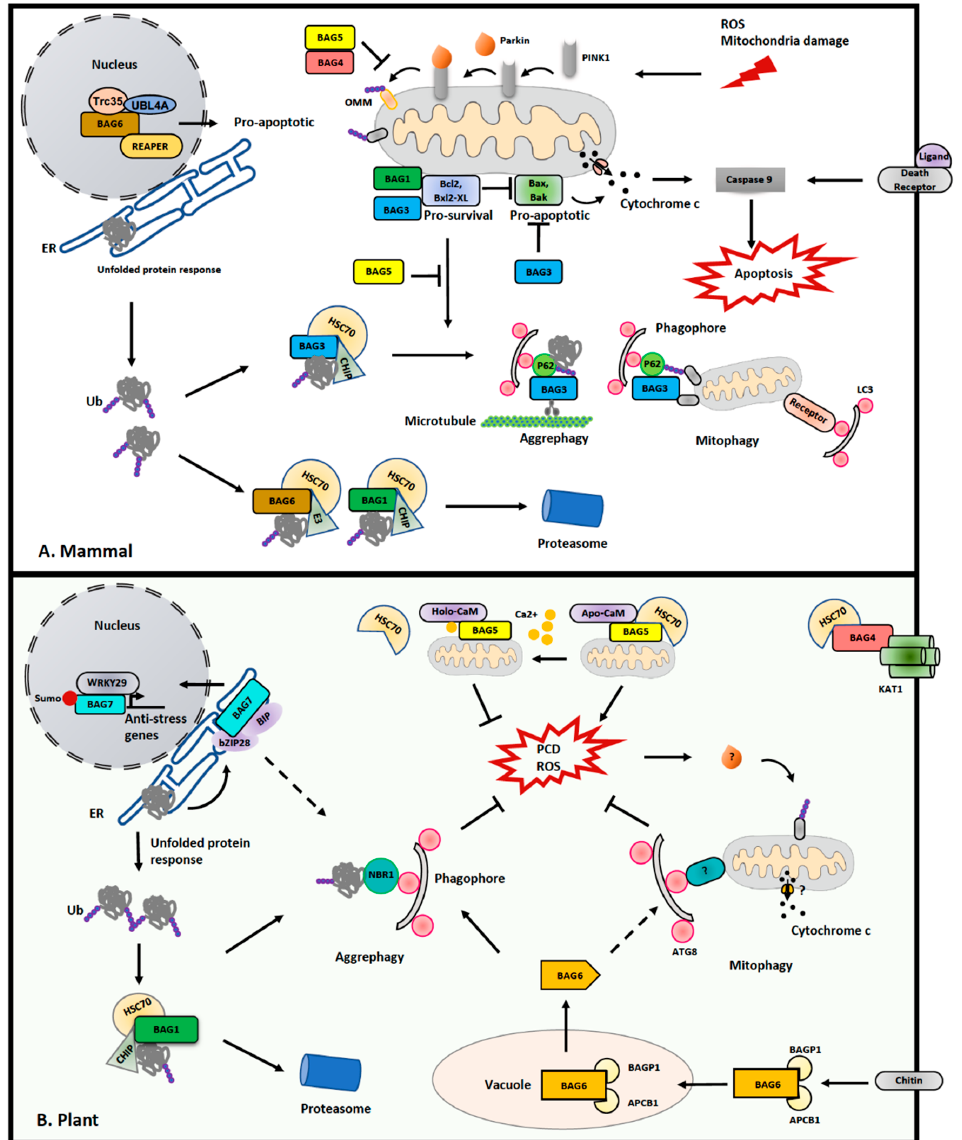
Figure 3. Functions of BAG families in mitochondrial homeostasis and PCD in mammals and plants. ( A ) Balance between anti-apoptotic and anti-survival Bcl-2 proteins determines the levels of the pro-death and pro-survival pathways. In addition, 6 isoforms of BAG proteins are coded in mammals, among which BAG1 mainly participates in unfolded protein response [133,134]; BAG3 induces autophagy by competing with BAG1 and binding with p62 as well microtubule regulator, or by directly binding with OMM protein to promote autophagy [135–138]; BAG4 and BAG5 both inhibit mitophagy by suppressing Parkin activity and pro-survival pathway [139,140]; BAG6 forms a ternary complex in the nucleus to promote pro-apoptotic activity via REAPER, and also participates in proteasome-mediated unfolded protein response [141]. ( B ) In plants, although no homologues of Bcl-2 proteins have been identified, seven isoforms of BAG proteins are found, which have diverse distributions. BAG1-3 has been implicated in binding to HSC70, mediating the unfolded protein response [132,142–144]; BAG4 has been shown to interact with the potassium channel KAT1 to participate in stomatal movement [145]; BAG5 is a mitochondrial-localized protein, whose activity is switched by Ca 2+ levels via regulating its binding affinity towards CaM and Hsc70 [146]; BAG6 requires a proteolytic process in the vacuole for its activation, which participates in pathogen response and autophagy as well [147,148]; BAG7 is an ER-localized protein, which forms a complex with Hsc70 ortholog BIP protein and bZIP28 upon ER stress [149]. Additionally, after cleavage, BAG7 will undergo SUMOylating and tranlocation to interact with the WRKY29 in the nucleus to regulate the expression of several anti-stress genes [150].